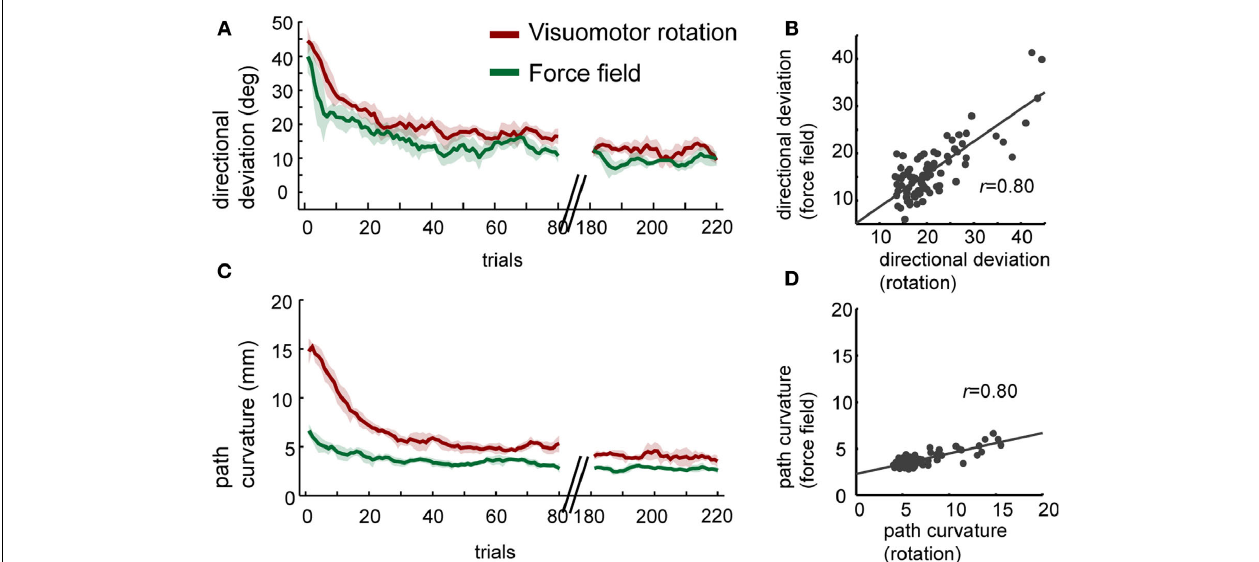
trials and last 40 trials are shown. (B) Correlation between the initial directional deviations in the fi rst 80 trials of force fi eld and of rotation. (C,D) As in A–B but for path